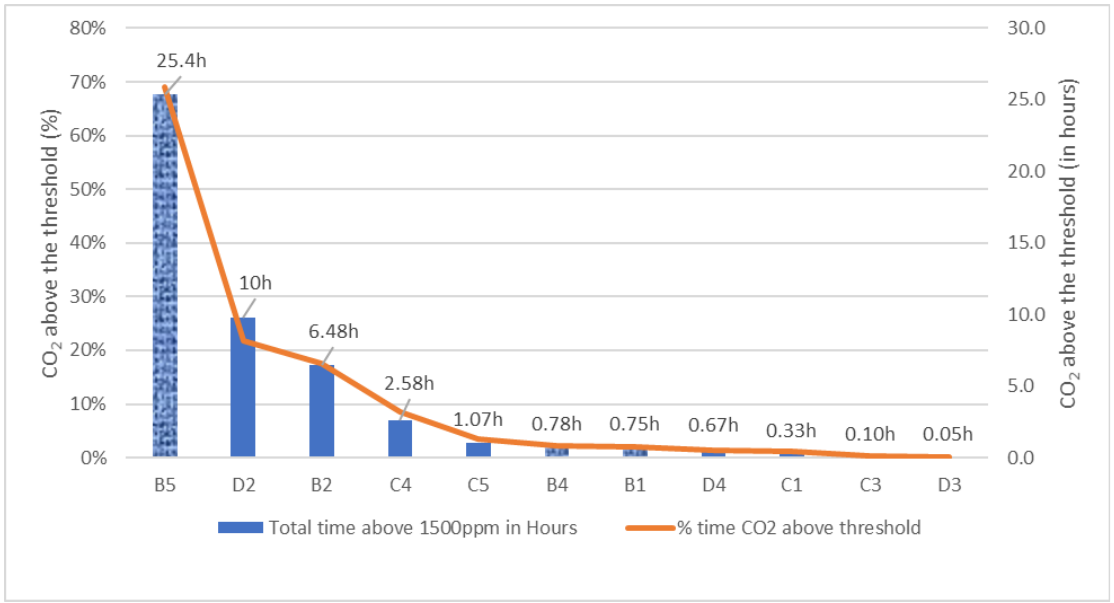
Figure 24. Classrooms with CO 2 concentrations above the threshold for more than 20 consecutives minutes.